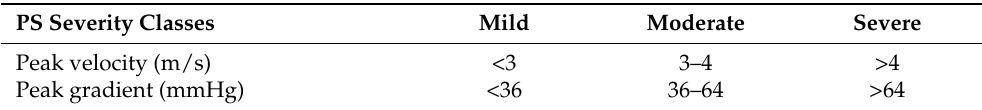
Table 1. Echocardiography grading of pulmonary stenosis